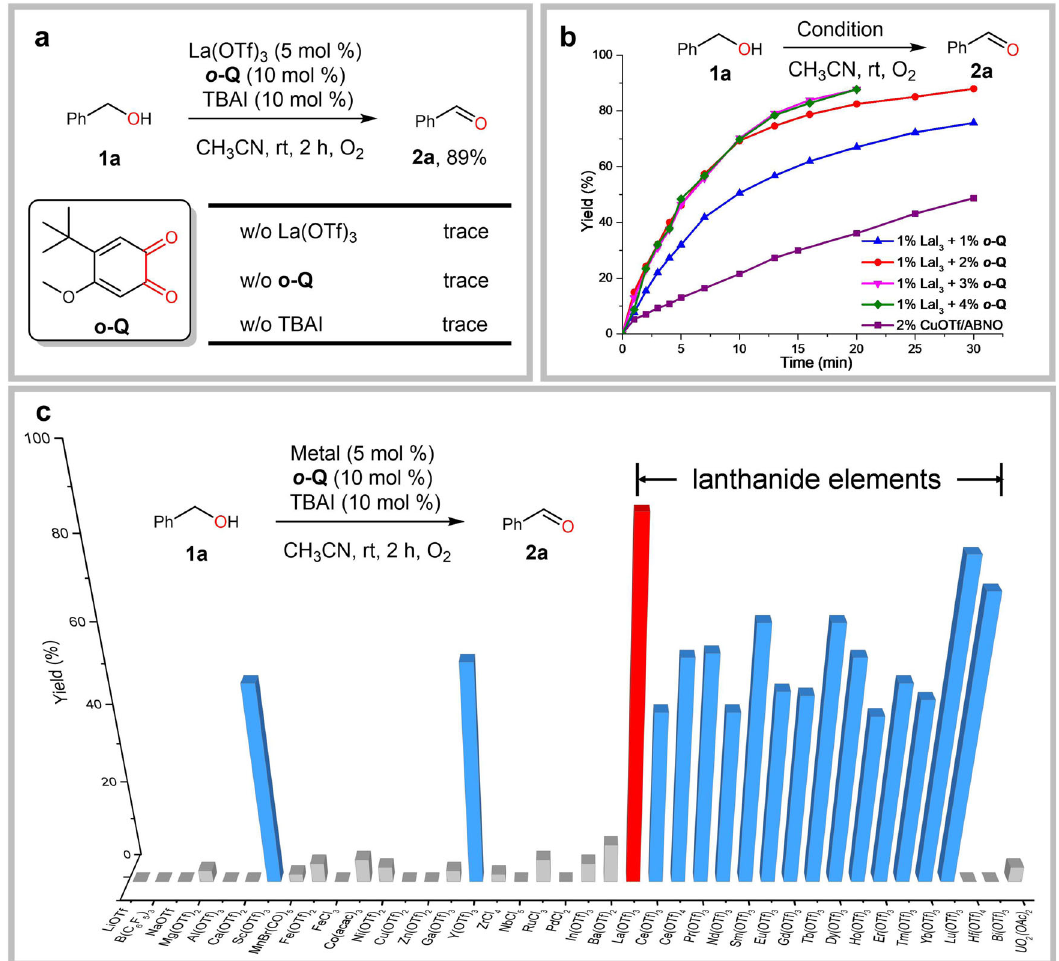
Fig. 2 Selected reaction details. a Control experiment. b Kinetic pro fi le of the reaction. CuOTf/ABNO condition: benzyl alcohol 1a (0.4 mmol), Cu(MeCN) OTf (2 mol %), 4-MeO bpy (2 mol %), ABNO (0.4 mol %), NMI (4 mol %), MeCN (4 mL), room temperature, O 2 balloon. c Metal screening (for details, see Supplementary Table 1). Unless noted, reactions were conducted on a 0.4 mmol scale with 0.6 mL MeCN at room temperature under 1 atm O 2 , and yields were determined by GC using 1,3,5-trimethoxybenzene as internal standard. TBAI = Tetrabutylammonium iodide. ABNO = 9-Azabicyclo[3.3.1]nonane